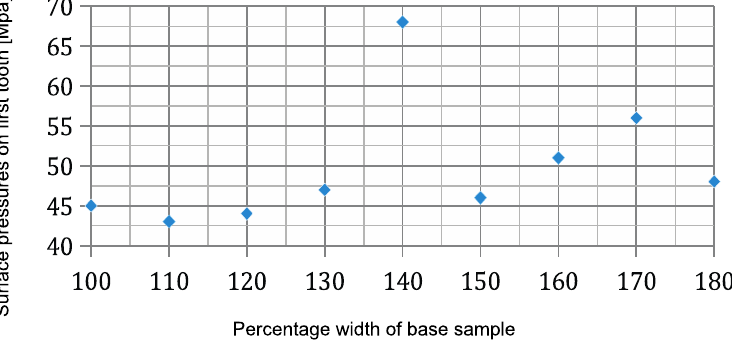
Figure 5. Surface pressure values on the first notch, depending on sample width.